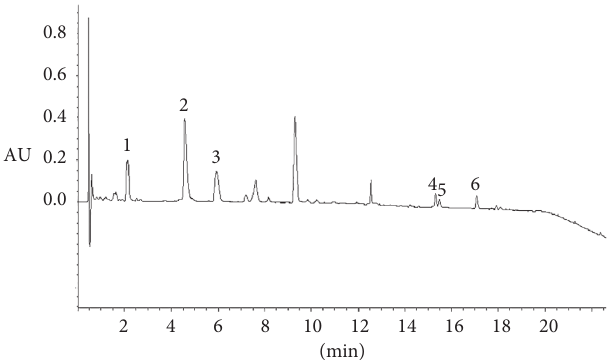
Figure 2: UHPLC chromatogram of RDN injection. 1: neo- chlorogenic acid; 2: chlorogenic acid; 3: cryptochlorogenic acid; 4: isochlorogenic acid B; 5: isochlorogenic acid A; and 6: iso- chlorogenic acid